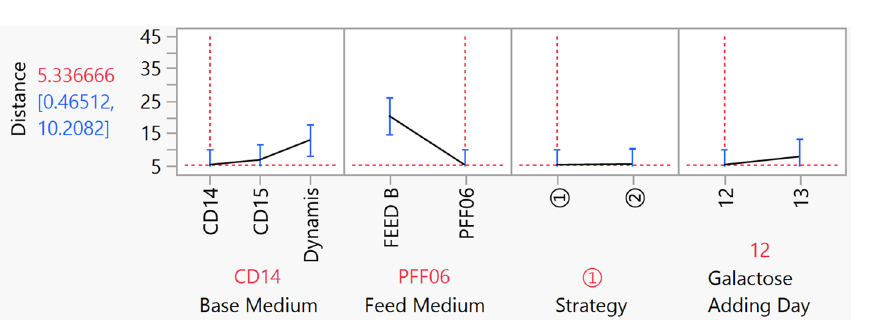
Figure 7. Effect evaluation of base medium, feed medium, strategy and galactose addition day on distance (Similarity). The image was created by JMP V15 (http:// www. jmp.